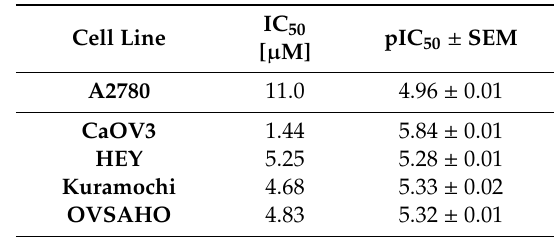
Table 1. IC 50 and pIC 50 for cisplatin after a 72h